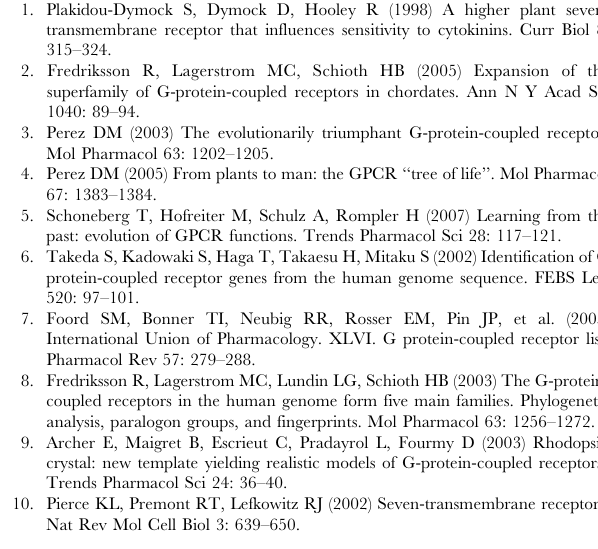
Table S2 Tenable PAML models representing molecu- lar evolution of 7TMs of class A non-olfactory human GPCR subgroups. PAML’s tenable models that represent molecular evolution of their 7TMs are illustrated across GPCR subgroups. Results from ‘‘random sites models’’ M3 vs. M0